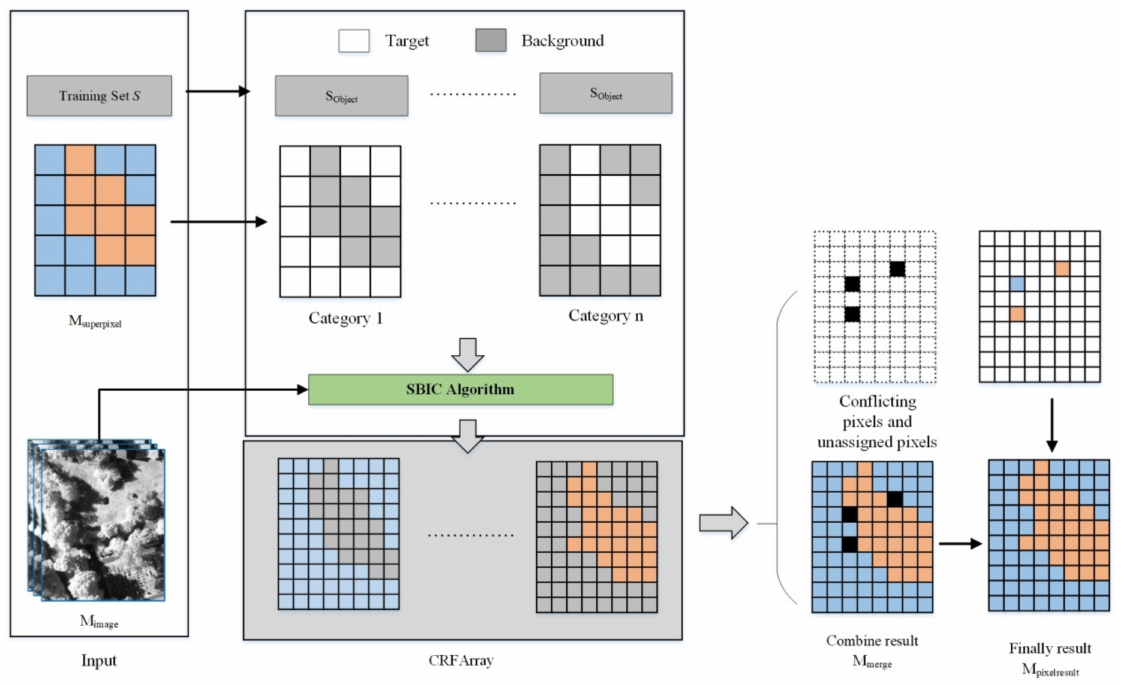
Figure 3. Process of the RCRF algorithm.